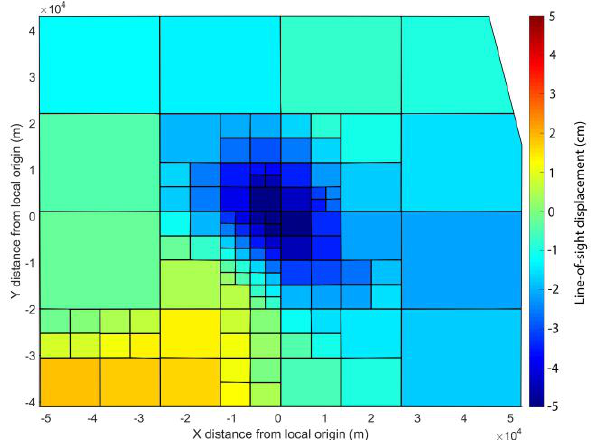
Figure 3. Down-sampled interferogram data of the area bordered by the dashed black square in Figure 2a using the quadtree decomposition algorithm. Negative values indicate motion away from the satellite along its LoS, while positive values indicate motion toward the satellite. Coordinates refer to a local origin (Longitude = 25.12°; Latitude = −22.63°).